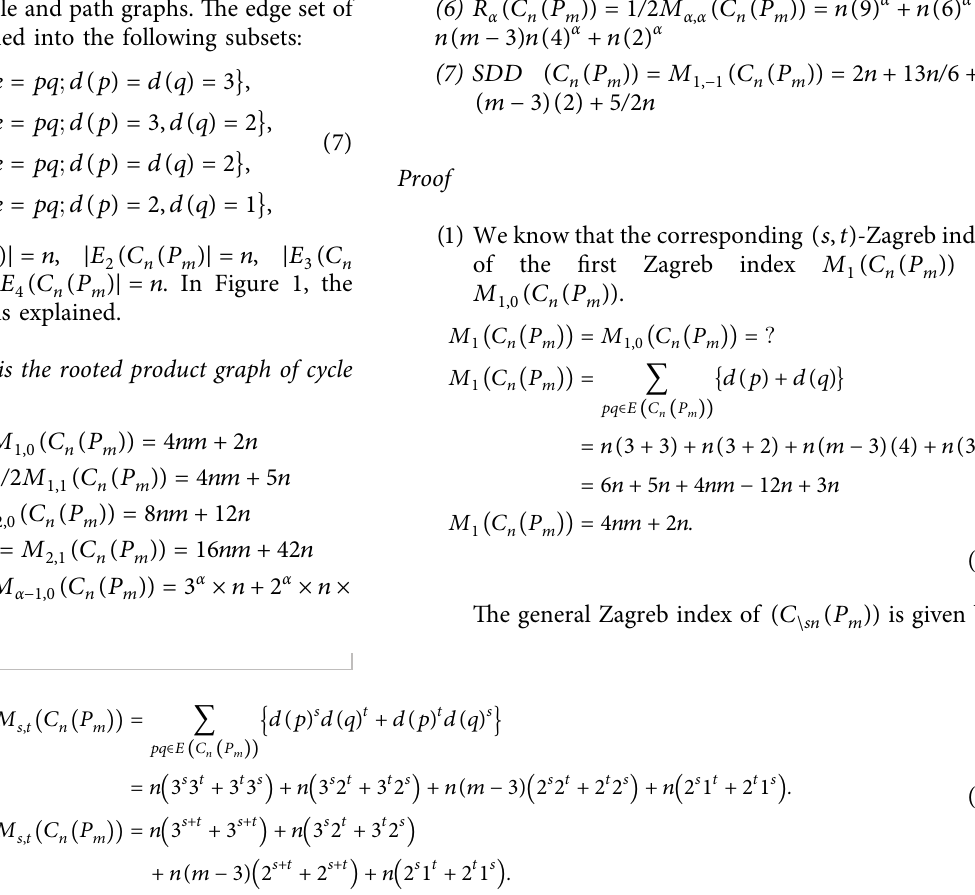
( P ) for n � 8 and m � n m